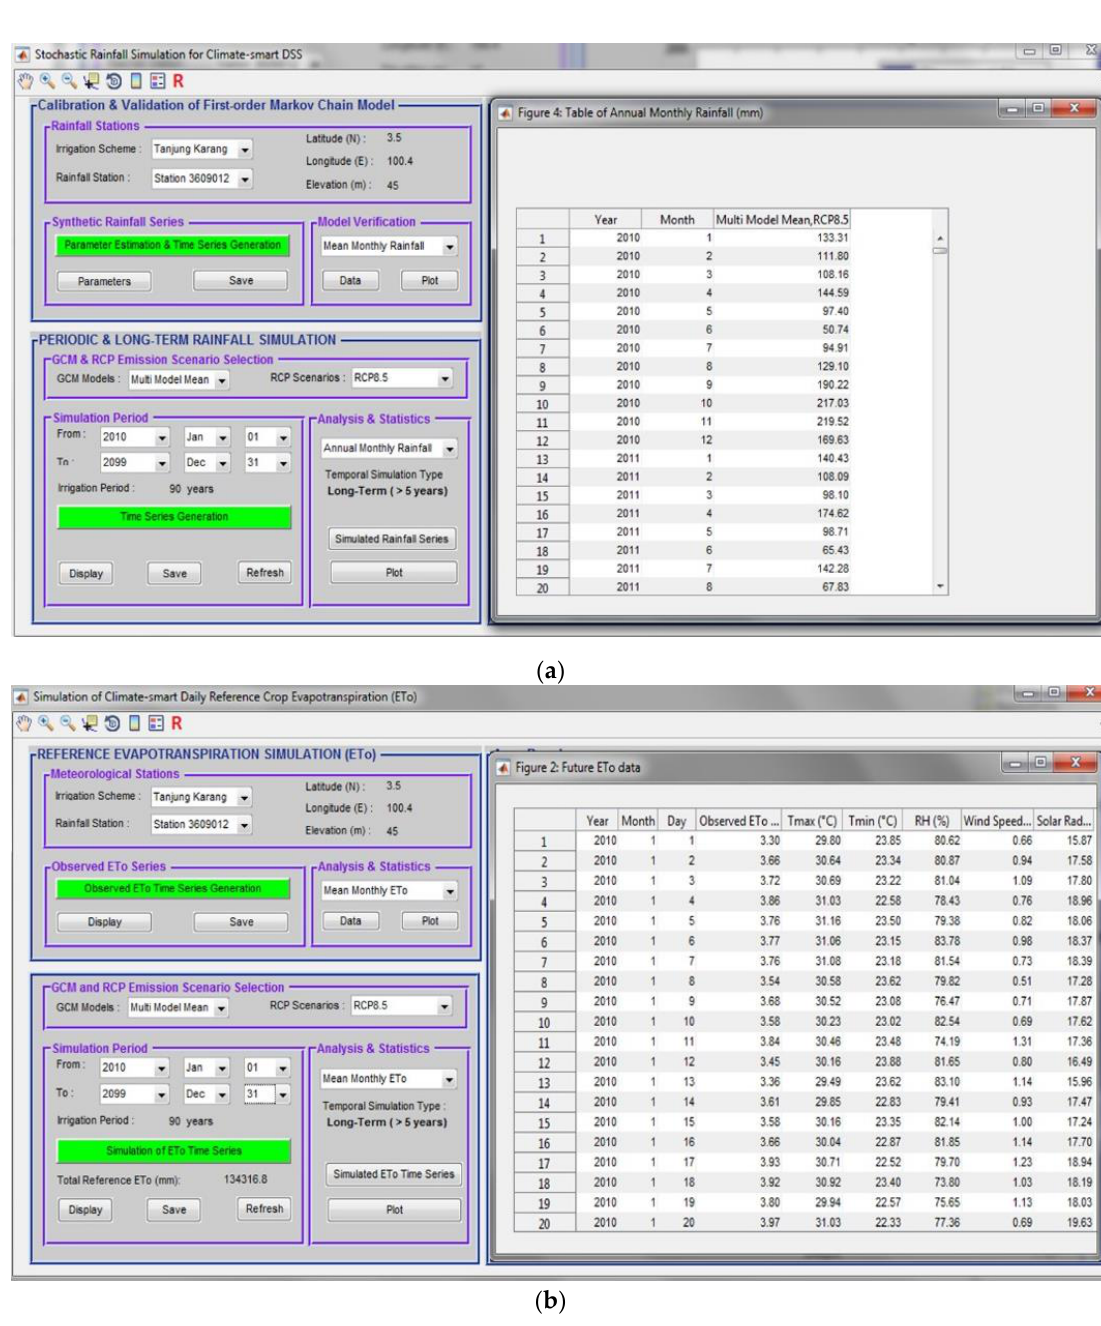
Figure 3. Windows for downscaling climatic variables time-series (2010–2099): ( a ) downscaling daily rainfall generation and ( b ) downscaling meteorological variables.